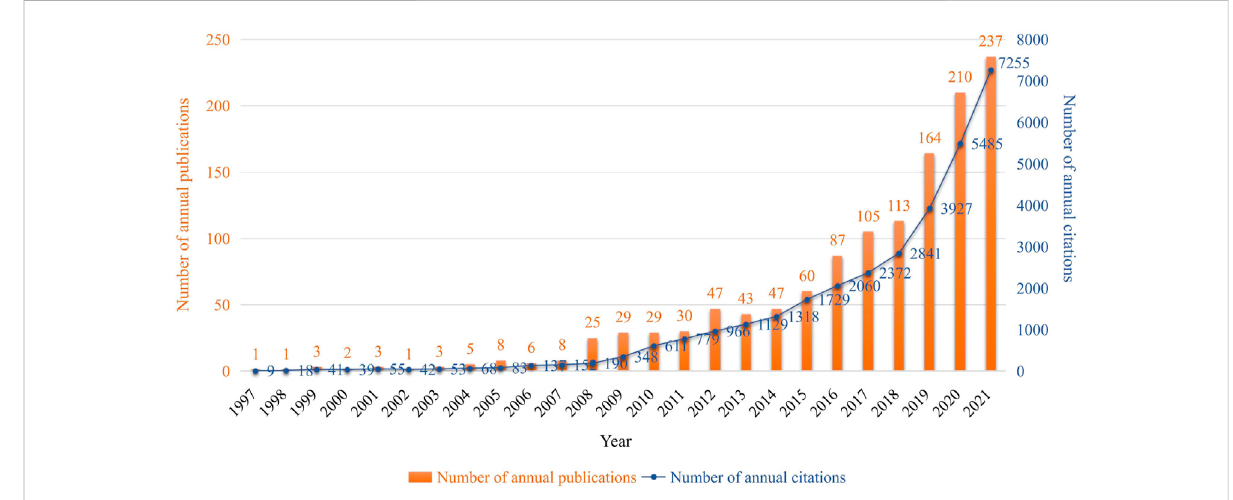
FIGURE 2 Distribution of annual publications and citations related to resistance of natural products to MDR bacteria from 1997 to